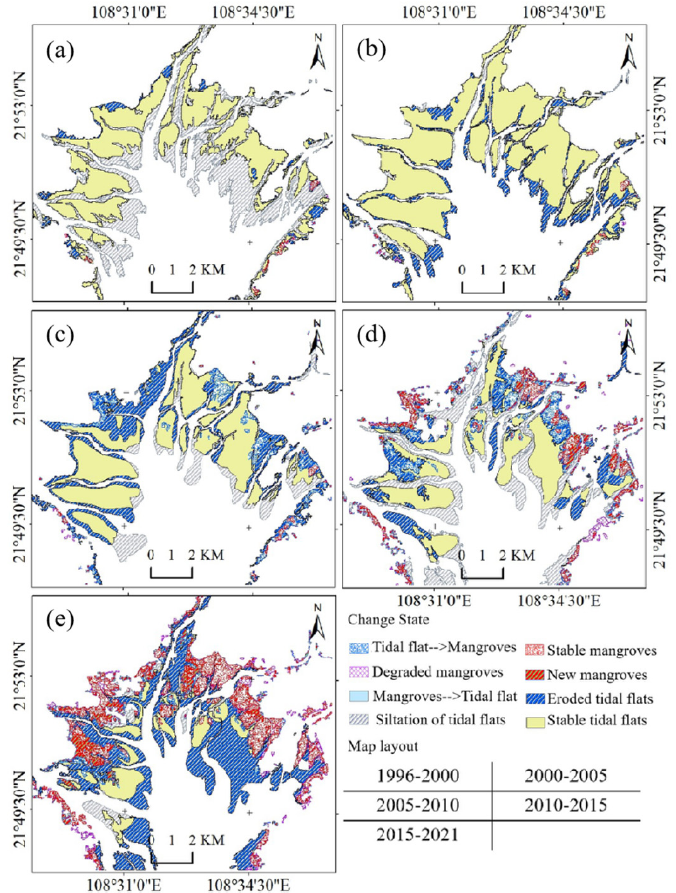
Figure 20. Tidal sequence change and centroid transfer of mangrove tidal fl at in Maowei sea area. ( a ) Interclass changes of mangroves and tidal fl ats in Maowei sea from 1996 to 2000. ( b ) Interclass changes of mangroves and tidal fl ats in Maowei sea from 2000 to 2005. ( c ) Interclass changes of mangroves and tidal fl ats in Maowei sea from 2005 to 2010. ( d ) Interclass changes of mangroves and tidal fl ats in Maowei sea from 2010 to 2015. ( e ) Interclass changes of mangroves and tidal fl ats in Maowei sea from 2015 to 2021.